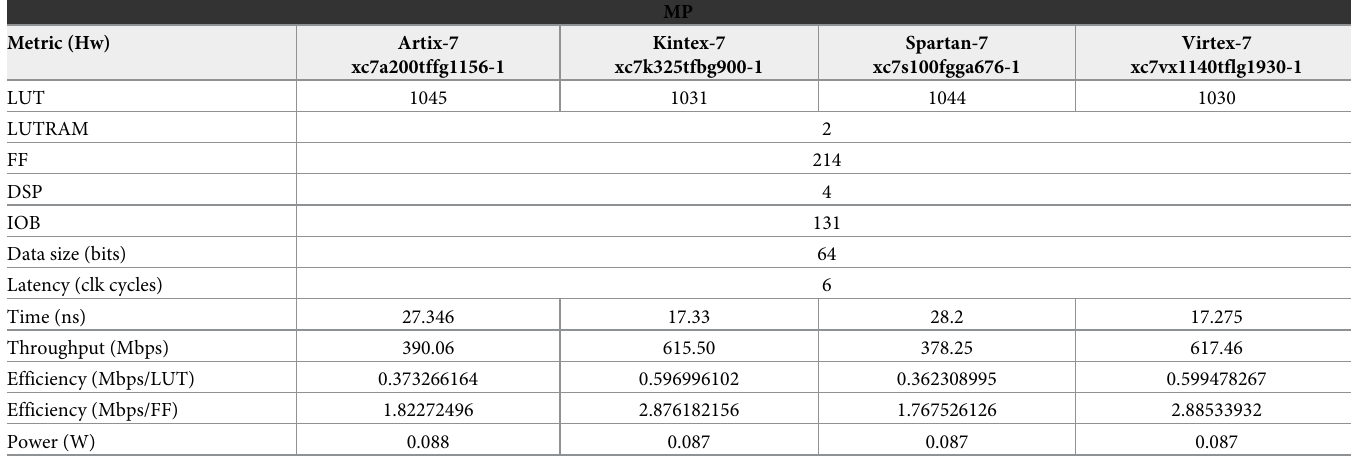
Table 5. Implementation results for the MP-based hardware